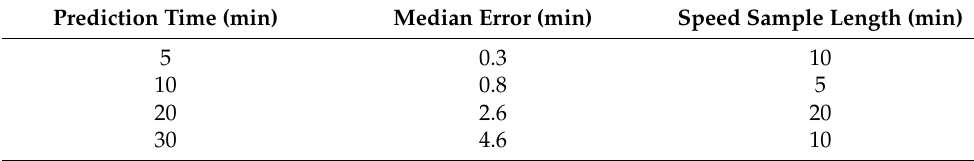
Figure 5. Prediction of time to reach runway based on median speed of sample. Table 3. Absolute error of best performing speed sample per prediction